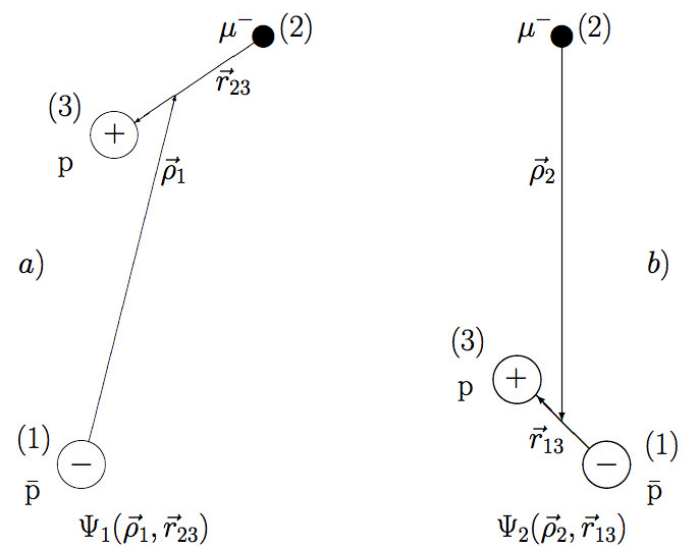
Figure 1. The three-body system ¯p, µ − ,p + or “123” is depicted in this figure. The only possible two asymptotic spacial configurations before the three-body break-up channel are presented together with their few-body Jacobi coordinates { (cid:126) ρ i , (cid:126) r jk } , where i (cid:54) = j (cid:54) = k = 1,2,3. Ψ 1 and Ψ 2 are the few-body